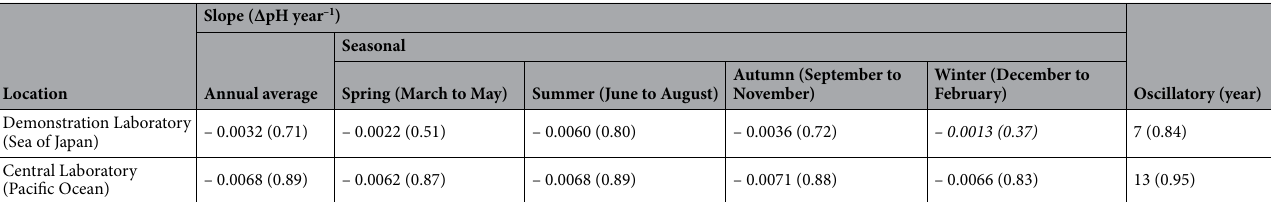
Table 1. Linear trends and oscillations in the ocean pH for the coastal regions of the Sea of Japan and North Pacific. The value in the parentheses shows the correlation coefficient: R. p -value of the slope was < 0.001, except for italics